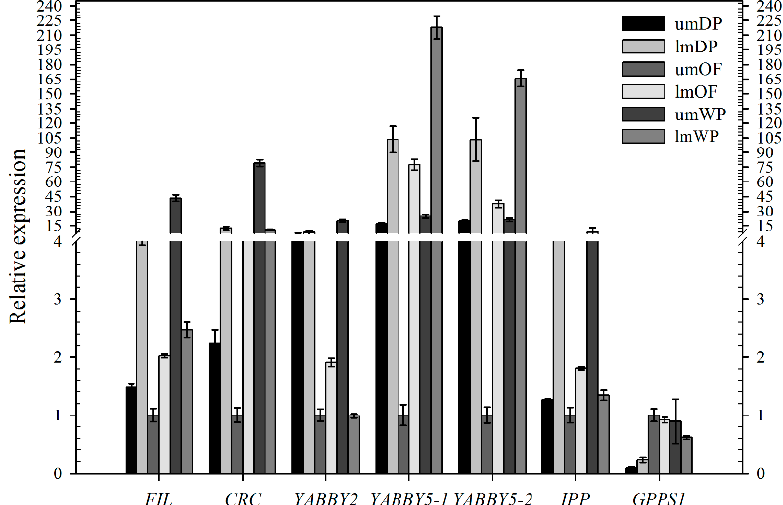
Figure 8. Quantitative real-time PCR analysis of different genes in the upper and lower halves of middle petals in DP, OF, and WP stages. Tublin homologous gene of C . praecox was used as an internal control. “um” and “lm” represent upper and lower half of middle petals,